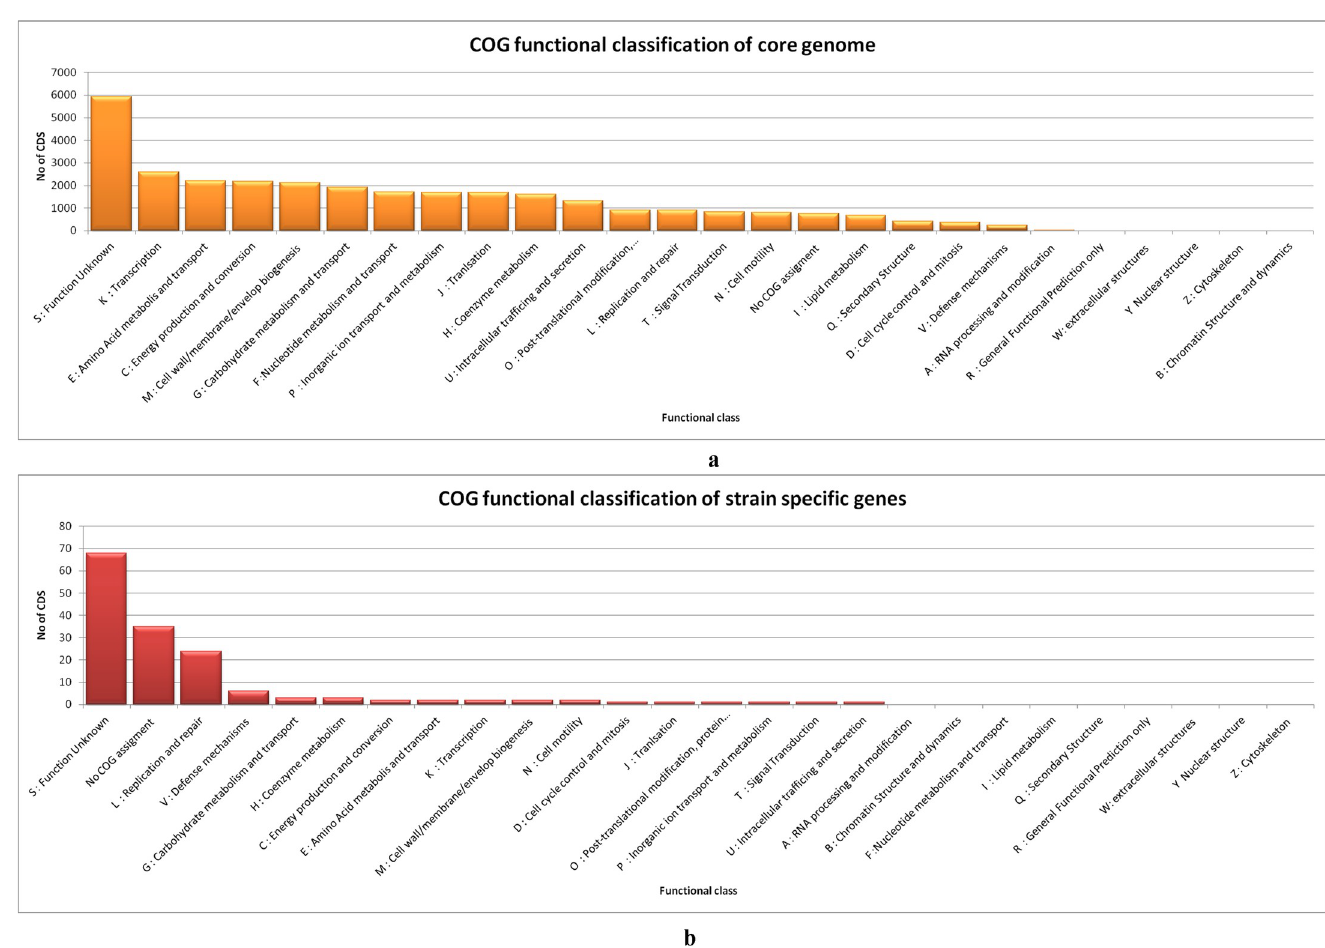
Fig 3. a) Distribution of COG functional classes in core genome of investigated Salmonella strains by eggnog mapper b) Distribution of COG functional categories in strain specific genes by eggnog